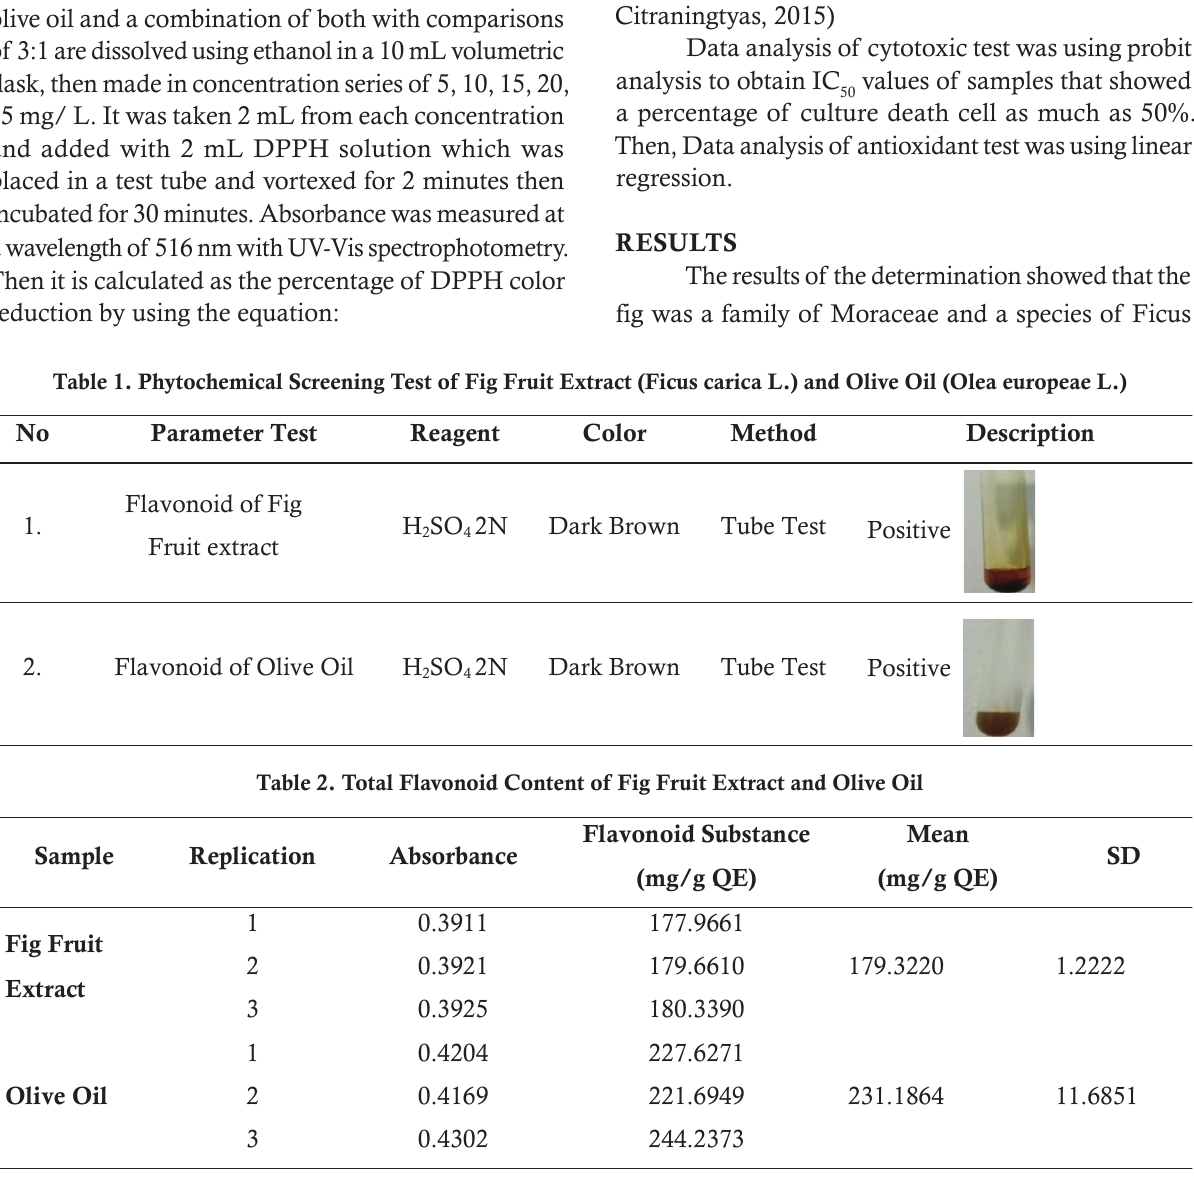
Table 1. Phytochemical Screening Test of Fig Fruit Extract ( Ficus carica L.) and Olive Oil ( Olea europeae L.)